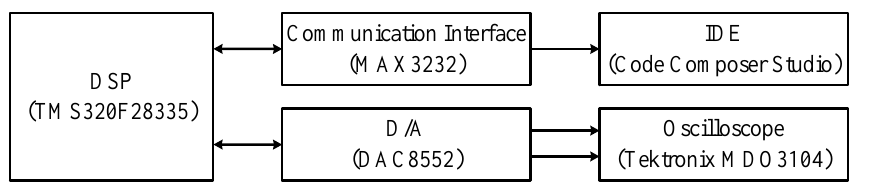
Figure 11. The digital signal processor (DSP) hardware connection schematic diagram of fractional- order memristor-based hypogenetic jerk